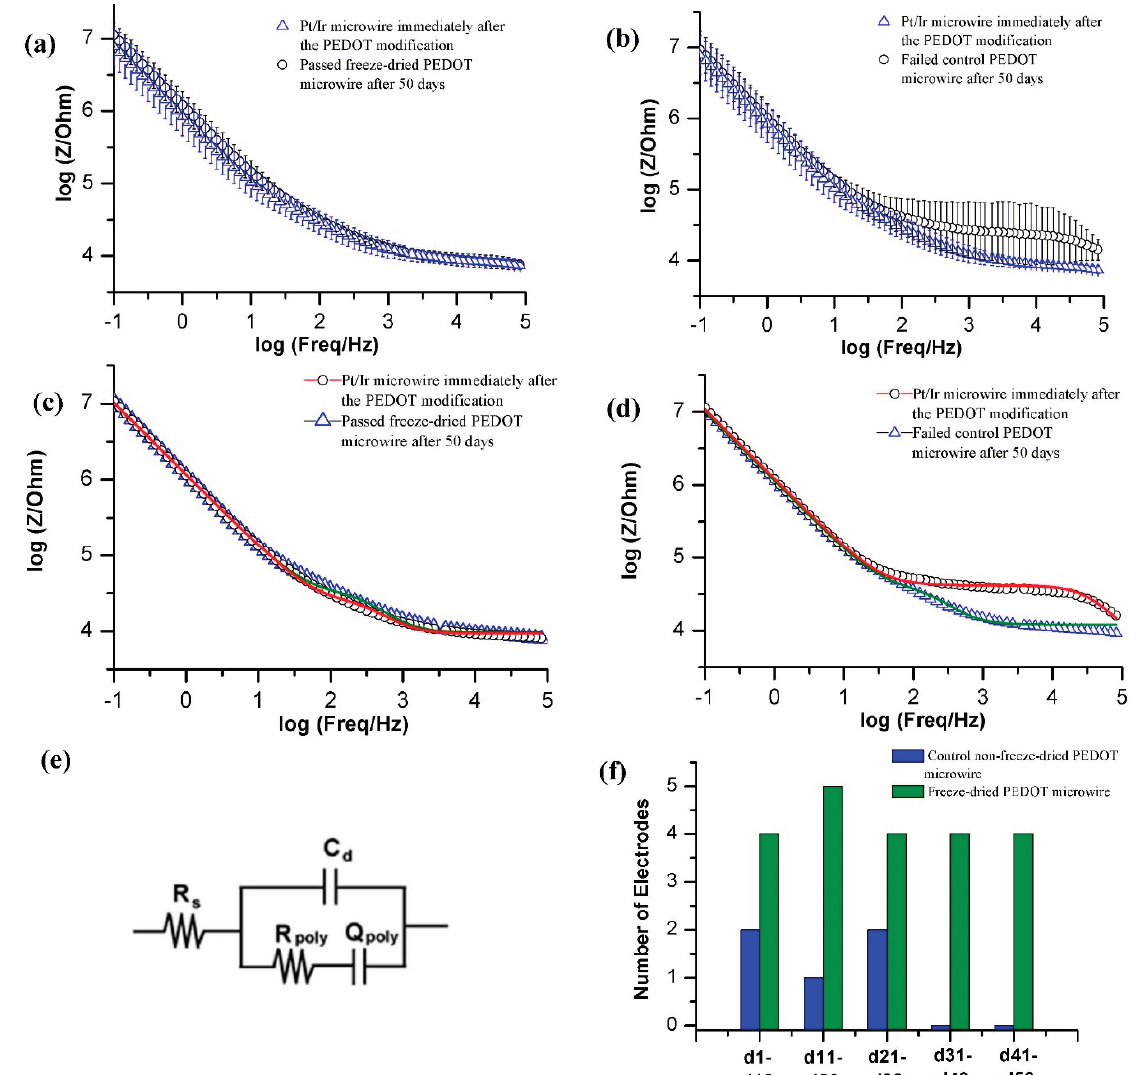
Figure 3. EIS data (with the coefficient of variation) in PBS, immediately after the PEDOT- PSS modification (blue triangle) and after 50 days (black circle) of: ( a ) passed freeze-dried microwires; ( b ) control failed microwires; ( c , d ) EIS data from one representative microwire from each group. The red and green solid lines in both figures indicate the respective fit; ( e ) The circuit used to fit the experimental EIS data; ( f ) Stability comparison of freeze-dried vs . control non-freeze-dried samples. Figure shows the number of passed microwires with less than 10% change in their original impedance at 1 kHz. The green and blue bars represent the passed freeze-dried and control microwires, respectively, out of 5 in each